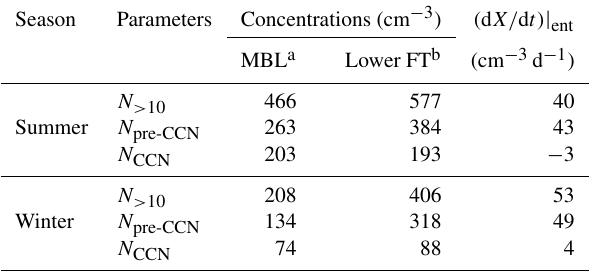
a Particle concentrations inside the MBL are averaged from 400 to 1000m for both seasons. b Particle concentrations in lower FT are averages between altitudes of 1600 and 2200m during summer and 2000 to 2600m during